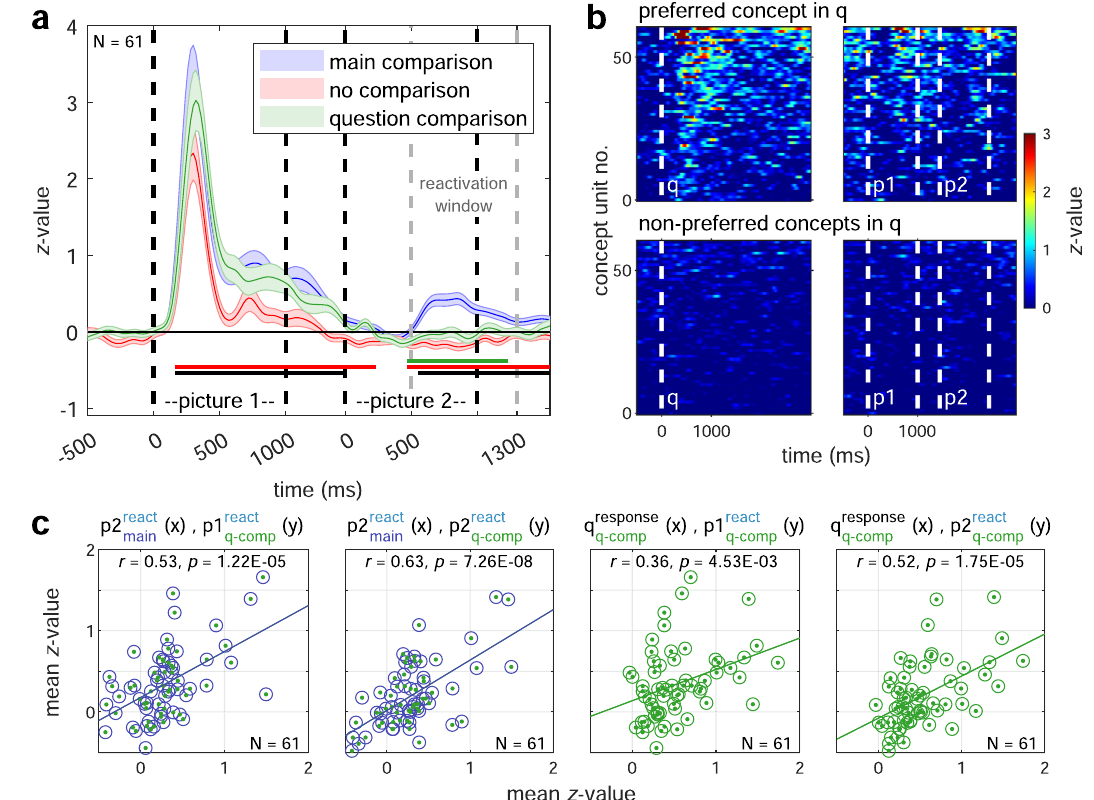
Fig. 2 Relational responses of the entire population of concept neurons. a Averaged normalized fi ring rates of concept neurons during both picture presentations in all three experimental conditions whenever the fi rst picture represented the preferred concept. Data are expressed as mean ± SEM (solid lines and shaded areas). Picture on- and offsets are marked by black dashed lines. Relational responses occurred during the reactivation window (gray dashed lines) in the main-comparison condition (blue), but not in the no- or question-comparison control condition (red and green, respectively). Time periods of signi fi cant z -value differences between main and control conditions (same colors) or zero (black) are indicated by solid lines ( p < 0.01;